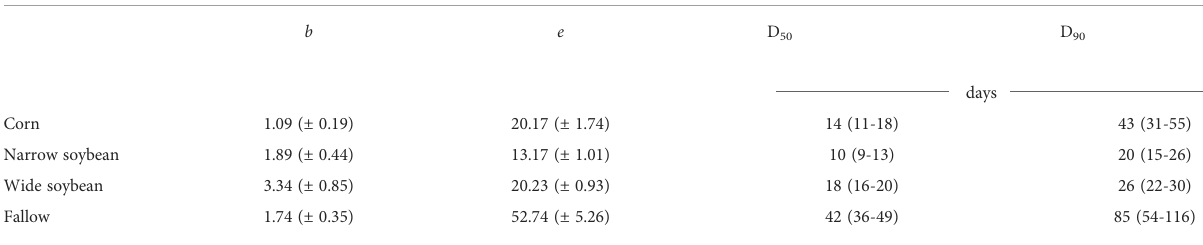
a Crop row spacing; narrow soybean – 38 cm; wide soybean – 76 cm; corn – 76 cm; b Nonlinear regression 3-parameter Weibull 2 model parameter estimates; b – slope, e – in fl ection point, standard errors are displayed in parentheses. Lower and upper limits of 95% con fi dence intervals for D 50 and D 90 are presented in